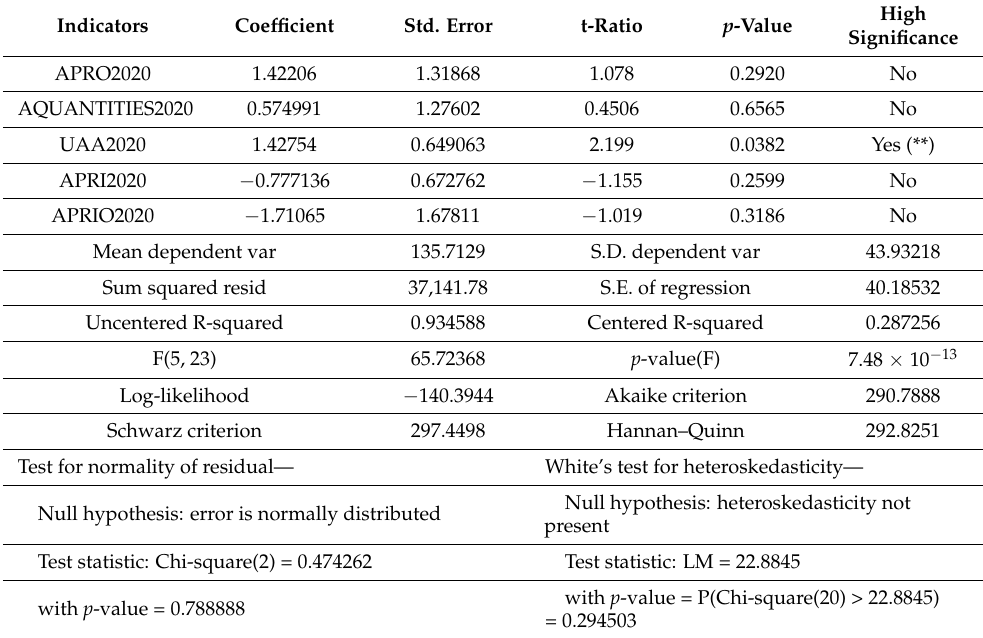
Table 10. Model 2020: OLS, using observations 1–28 (Dependent variable: